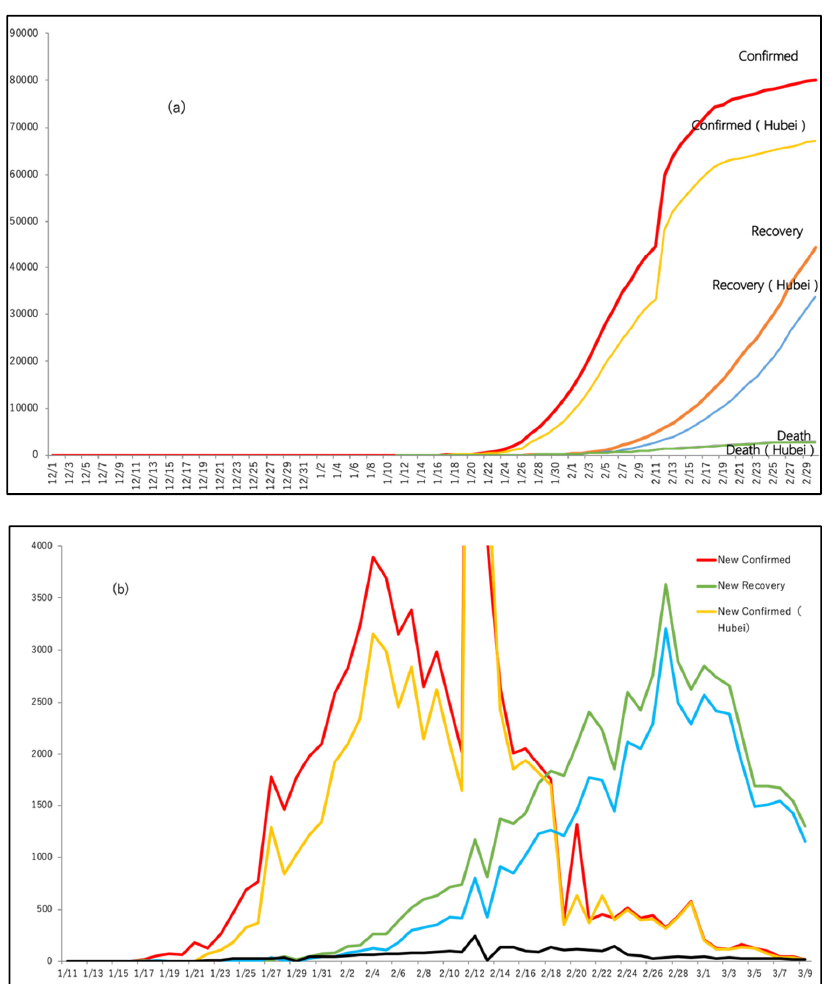
Figure 1a. Number of people affected, recovered, and dead in China and Hubei province; Figure